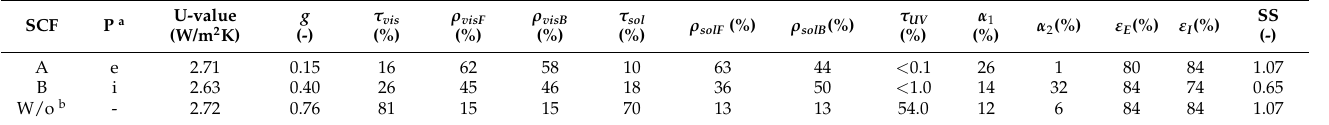
Table 1. Optical and thermal properties of the analyzed glazing systems that were computed with Optics and Window software (glazing systems arranged by increasing visible transmittance): thermal transmittance, U-value; solar heat gain, g; visible transmittance, τ vis ; visible front, ρ visF , and back, ρ visB , reflectance; solar transmittance, τ sol ; solar front, ρ solF , and back, ρ solB , reflectance; ultraviolet transmittance, τ UV ; absorptance of the external, α 1 , and internal, α 2 , glass panes; thermal emissivity of the external, ε E , and internal, ε I , glazing surfaces; spectral selectivity ( τ vis / g ), SS.